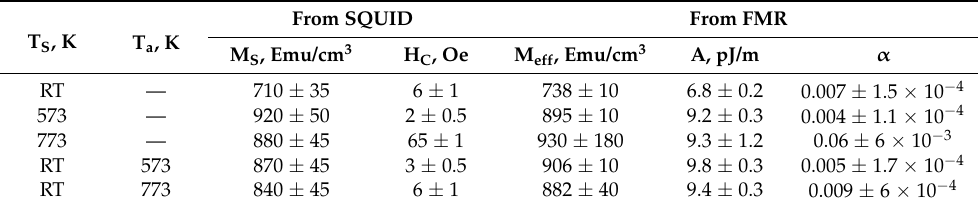
Table 2. Deposition temperature (T S ), temperature of annealing (T a ), saturation magnetization (M S ) and coercive field (H C ) determined from SQUID measurements, effective magnetization (M eff ), exchange stiffness (A) and damping parameter ( α ) determined from FMR measurements. Error margins for M S were estimated from uncertainty of the sample size determination. Error margins for FMR measurements were derived from fitting